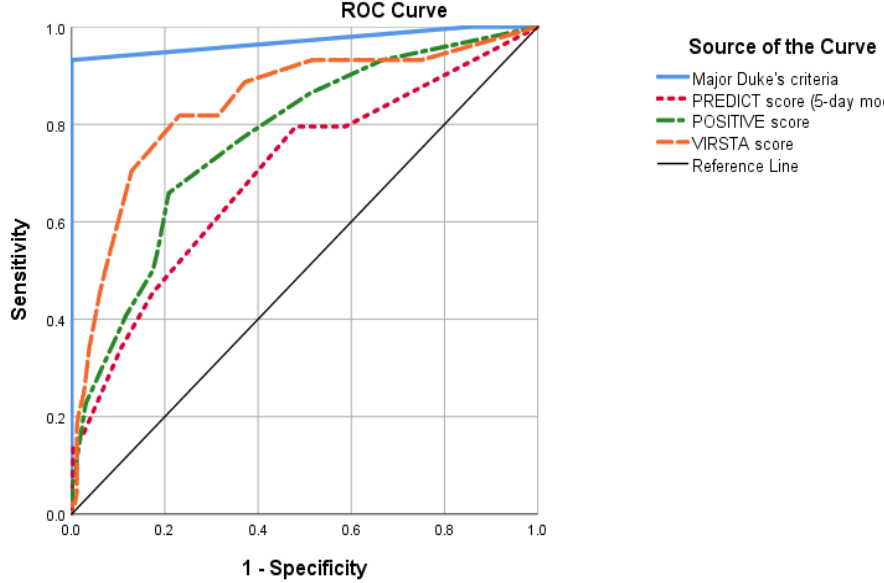
Figure 1. Receiving operator curve of different clinical prediction rules. AUC for PREDICT score (5-day model) was 0.699 (IC 95% 0.609–0.788). AUC for POSITIVE score was 0.771 (95% CI 0.696–0.846). AUC for VIRSTA score was 0.842 (0.771–0.912). In comparison, fulfilling major Duke’s criteria had an AUC of 0.971 (95% CI 0.94–1.00). AUC: Area under the receiving operator